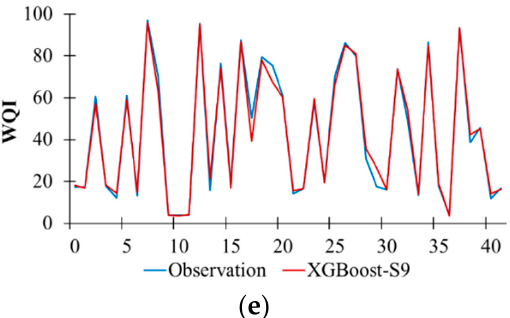
Figure 2. Temporal variation in the observed and predicted WQI values for the best performance models using boosting-based algorithms during the testing period. ( a ) AdaBoost-S2. ( b ) GBM-S7. ( c ) HGBM-S2. ( d ) LightGBM-S6. ( e ) XGBoost-S9.